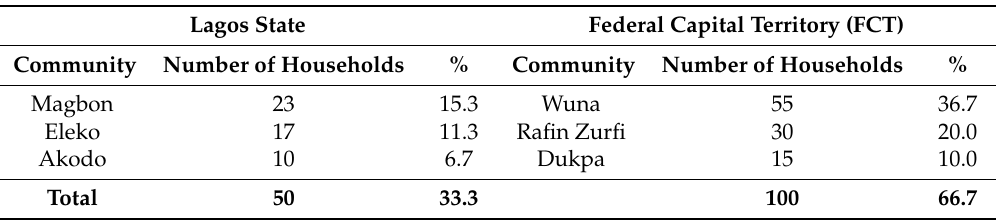
Table 1. Communities selected for the survey along with the number of households (HH) in each